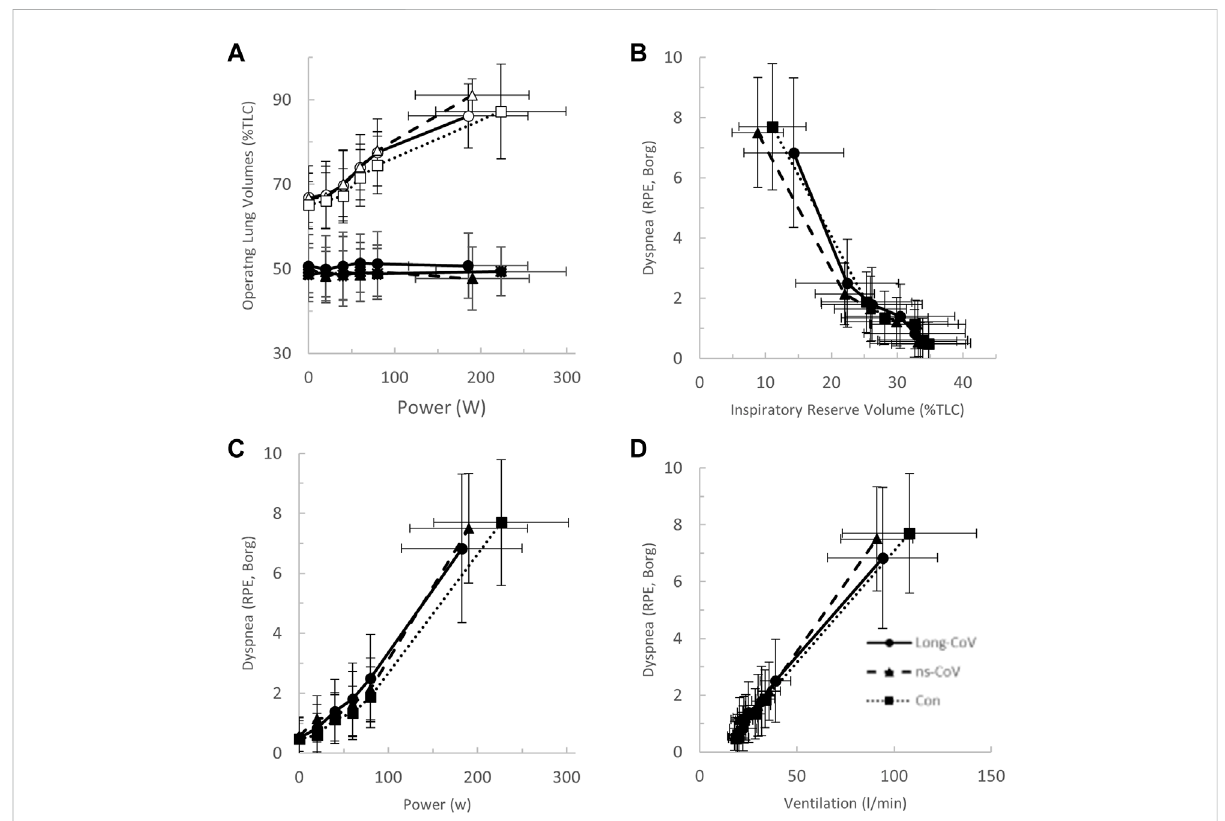
FIGURE 4 (A) The operating lung volume-power (open, end-inspiratory lung volume, closed, end-expiratory lung volume); (B) dyspnea-inspiratory reserve volume (as percent of total lung capacity, TLC); (C) dyspnea-power (Borg rating of perceived exertion, RPE); and (D) dyspnea-ventilation relationships in Long-CoV (circles, solid line), no-longer symptomatic (ns)-CoV (triangles, dashed line) and Con (squares, dotted line). No signi fi cant